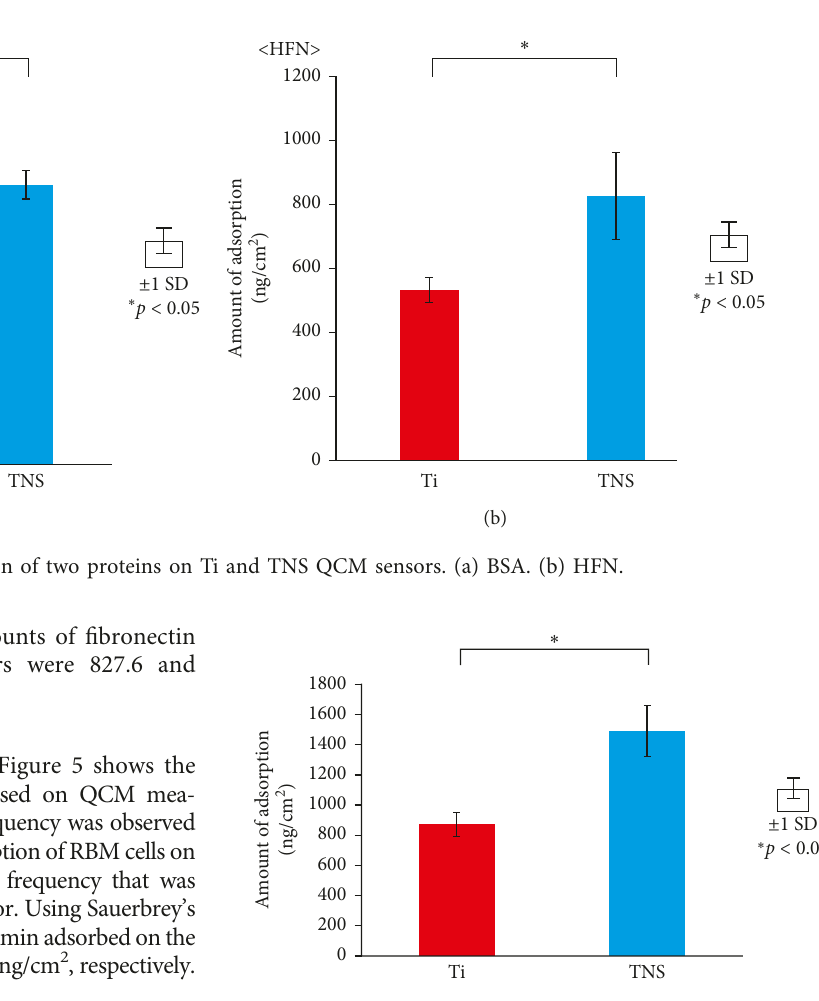
Figure 5: Adsorption of rat bone marrow cells on Ti and TNS QCM